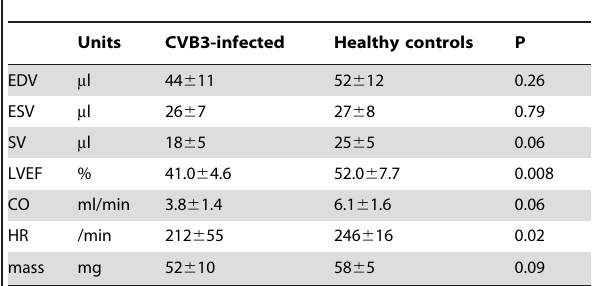
Table 1. Left ventricular function parameters of CVB3- infected mice compared to age matched healthy controls at